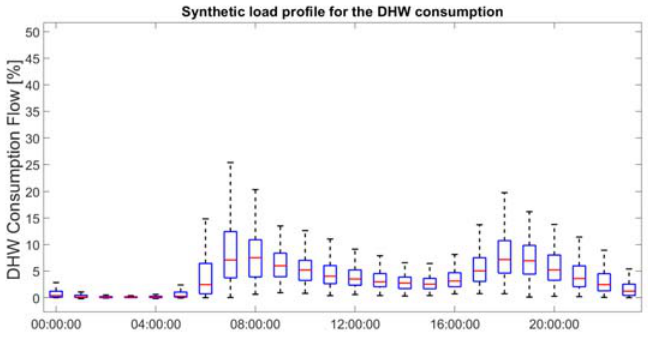
Figure 1. Synthetic hourly load profile for the domestic hot water consumption in dwellings, based on